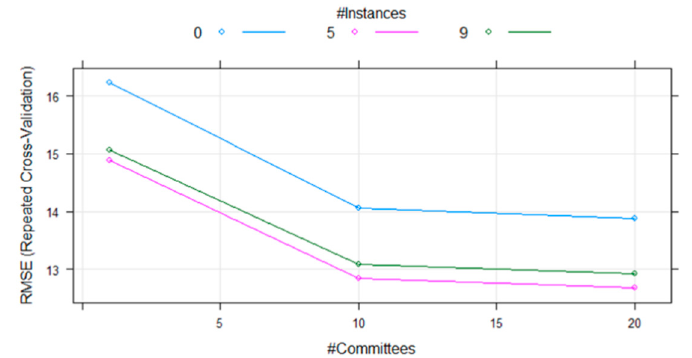
Figure 4. The cross-validated RMSE (Root Mean Square Error) curve for different commit sizes and instance numbers.